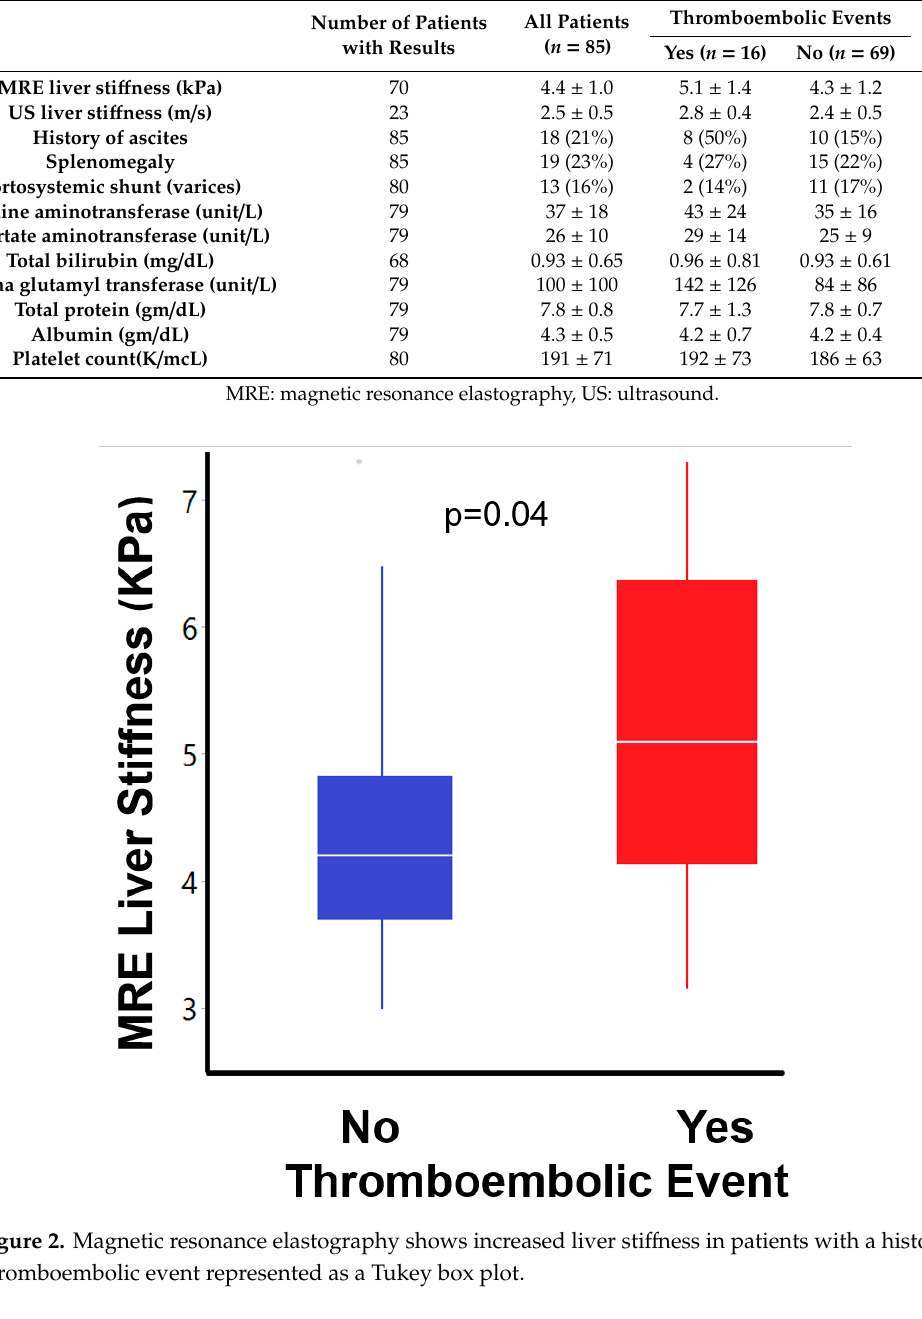
Table 3. Laboratory and liver imaging results in patients with and without thromboembolic events.